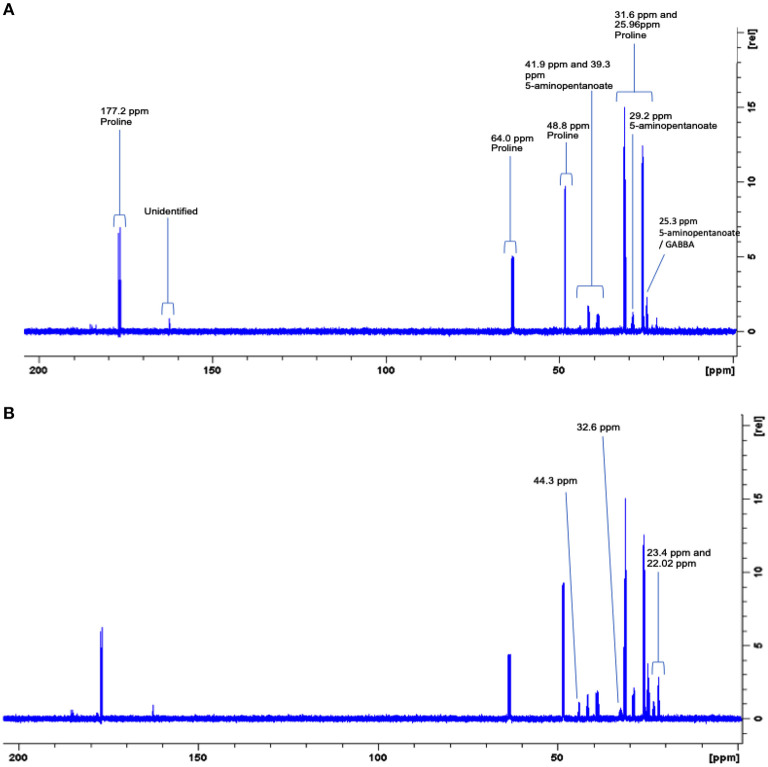
Representative full 600 MHz 1D C13 NMR spectra for one day 4 (A) and day 7 (B) 10 mM C13-labeled proline supplemented biofilm spent saliva. Identification and chemical shift (ppm) of metabolite peaks are labeled in (A) and additional peaks identified at day 7 are labeled in (B).